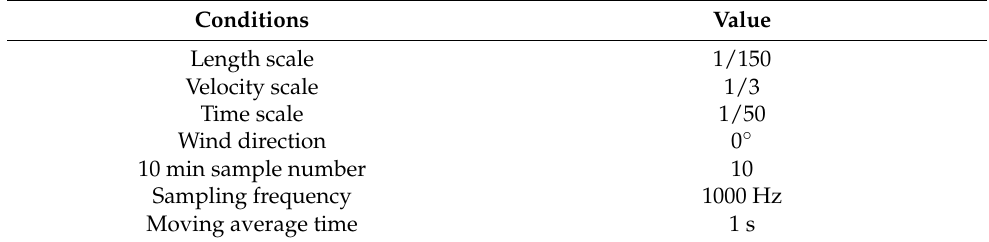
Figure 3. Characteristics of oncoming flow: ( a ) mean velocity and turbulence intensity profiles and ( b ) power spectra of velocity fluctuation at z = 0.24 m. Table 2. Experimental conditions.